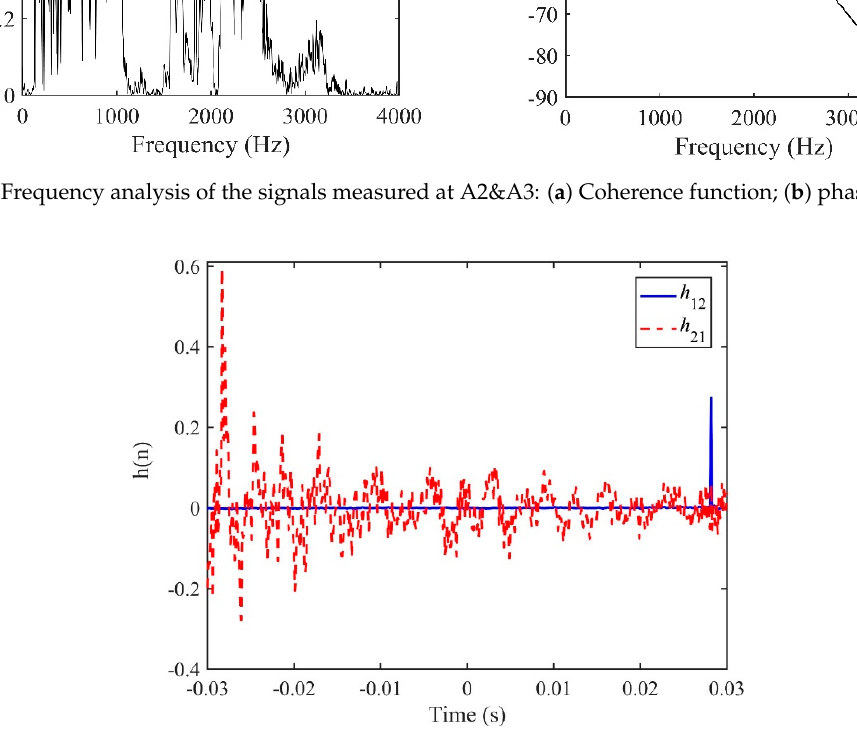
Figure 14. IRFs between the signals measured at A2&A3 using the conventional LMS adaptive